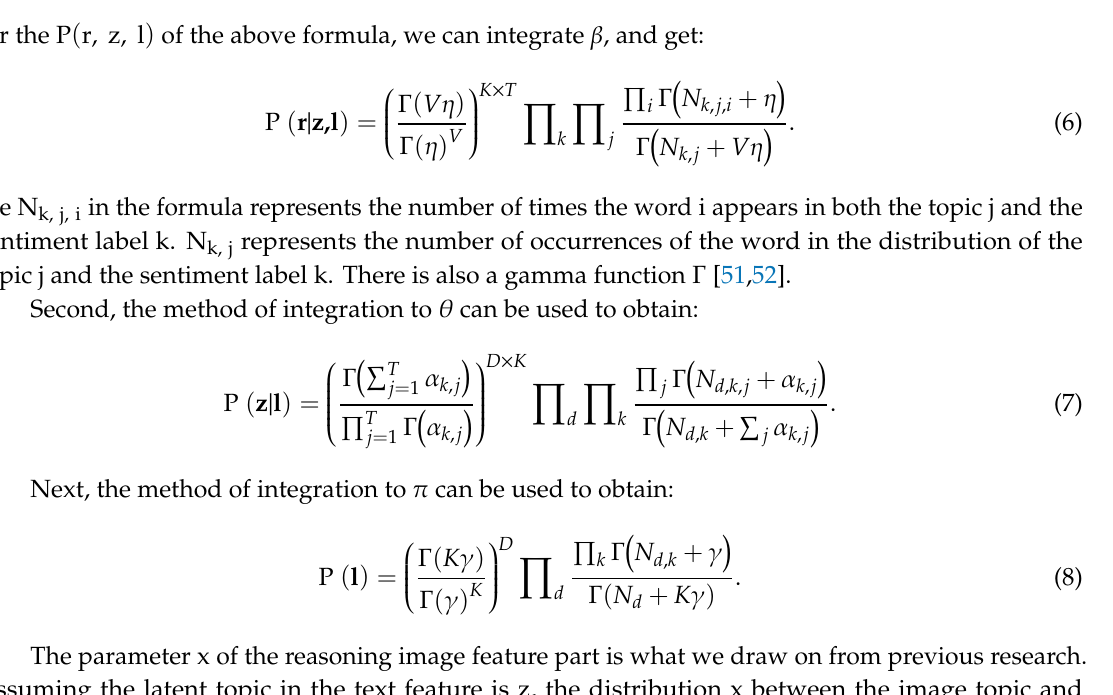
Figure out the real text word r with the parameter β z